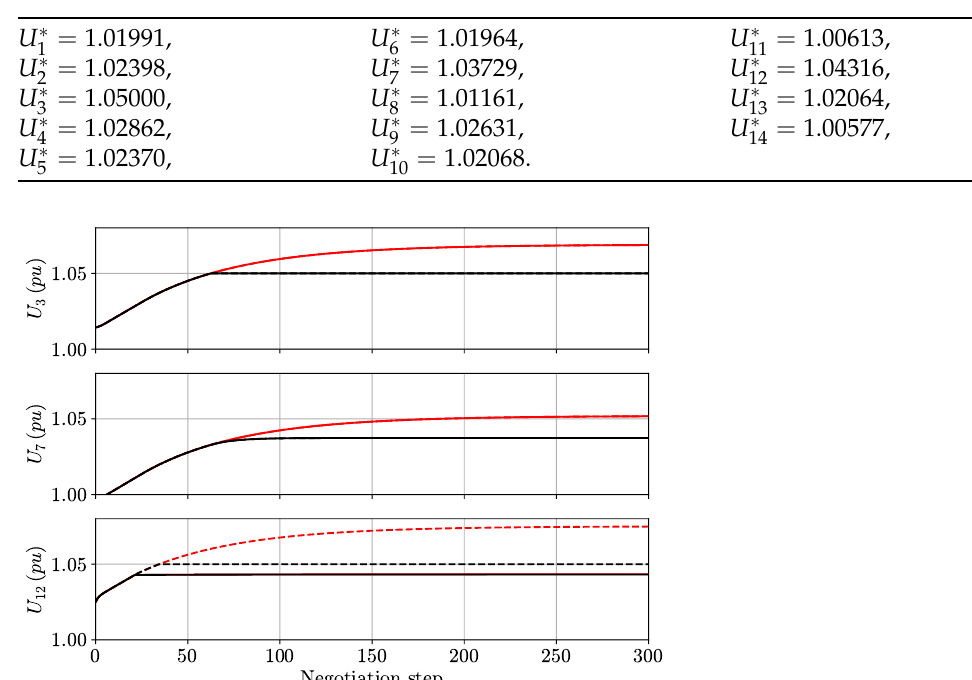
Table 5. Voltage level at the equilibrium for Example 2.